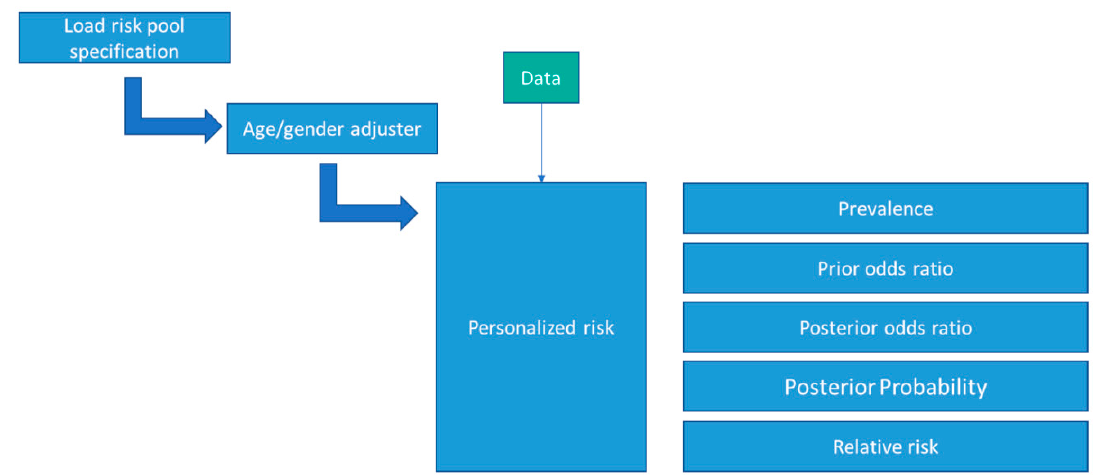
Figure 3. The DSS multi-step computation process.